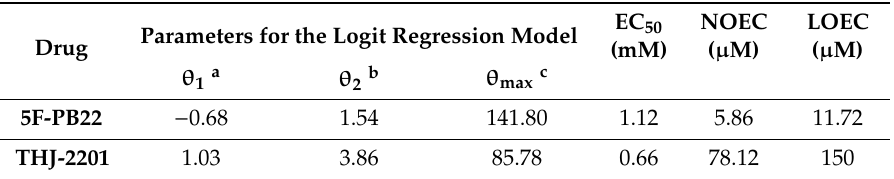
Table 1. Estimated parameters for the Logit model (best-fit regression) of 5F-PB22 and THJ-2201 in the 3-(4,5-dimethylthiazol-2-yl)-2,5-diphenyltetrazolium (MTT) reduction assay, after 24 h-incubation of non-di ff erentiated NG108-15 cells, at 37 ◦